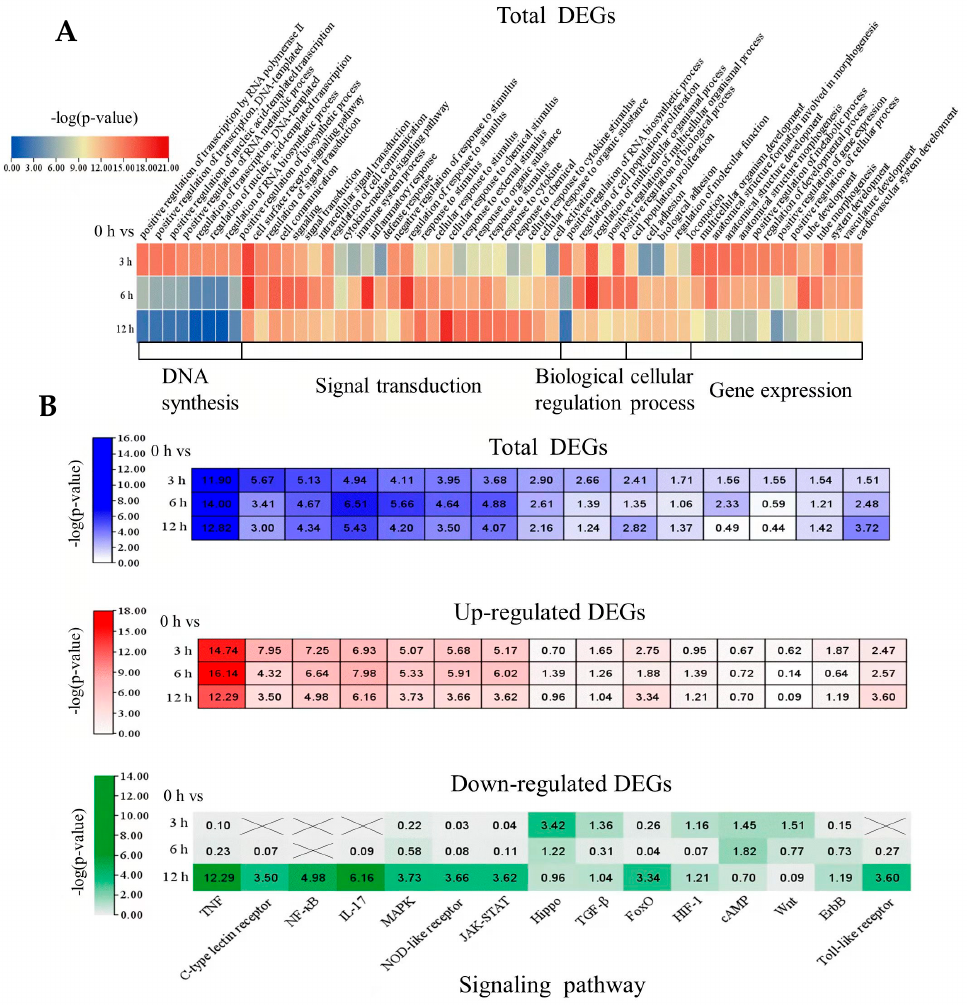
Figure 4. Biological processes and pathways derived from oleodaphnone treatment in NH2 cells.